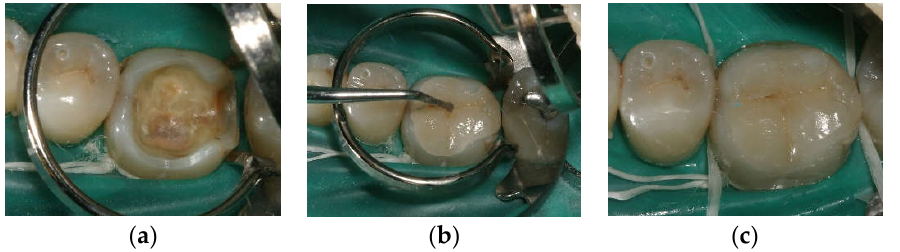
Figure 1. ( a ) The inlay preparation; lower molar, class IIOD cavity; ( b ) Try-in of the inlay; ( c ) Lithium disilicate inlay in situ.